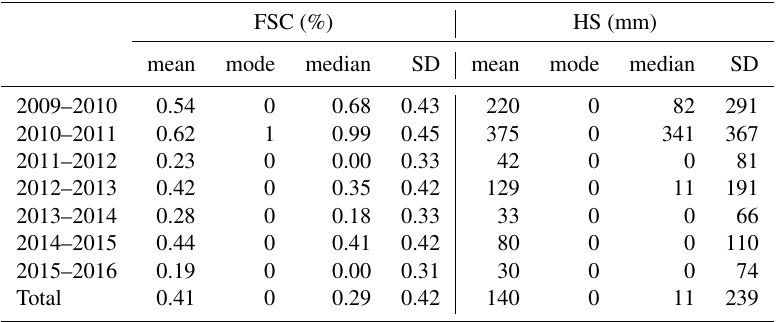
Table 3. Selected statistical annual descriptors of the daily fractional snow cover (FSC) and height of snow (HS) during the snow season (1 November–31 May) in the C2 scene at the Refugio Poqueira experimental site in the Guadalfeo Experimental Catchment (located by PG2, 2510ma.s.l.; Fig. 2). SD refers to standard deviation. FSC (%)